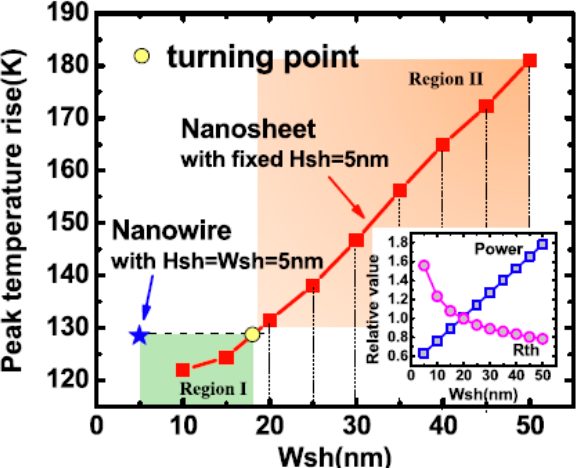
Figure 28. Peak temperature rise in nano-sheet FETs with increased width of nano-sheets (Wsh) [179]. H sh stands for height or thickness of nano-sheets.